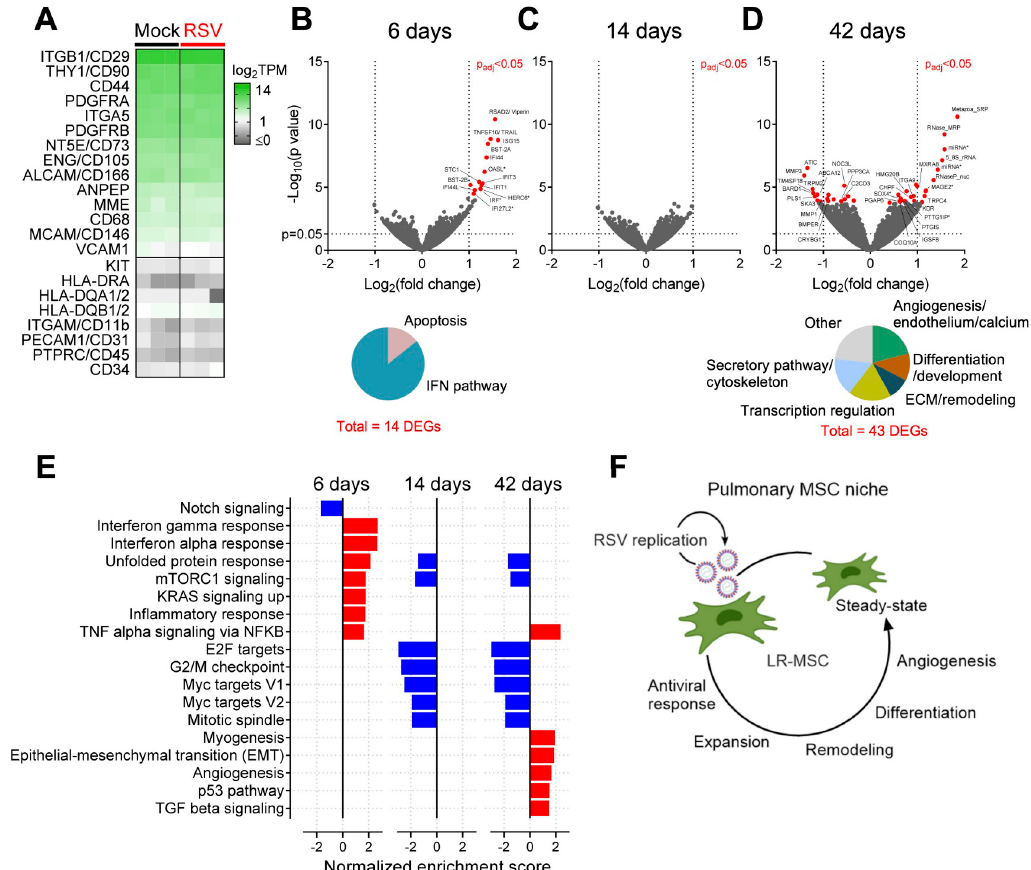
Fig 6. The transcriptional activity of LR-MSCs is related to the phases of RSV disease. (A) Expression levels of selected classical MSC markers expressed as log 2 TPM (TPM, transcripts per million). Each column is a different time p.i. (6, 14, and 42 days p.i.). (B-D) Volcano plots of the DEGs from the comparison of RSV infection and mock control 6 (B), 14 (C), and 42 (D) days p.i. with p adj < 0.05 (red filed circles). (B) Pie chart with the 14 DEGs 6 days p.i. (p adj < 0.05) categorized according to their function. (D) Pie chart with the 43 DEGs 42 days p.i. (p adj < 0.05) categorized according to their function. (E) Normalized enrichment score of significant (false discovery rate, FDR < 0.05) hallmark gene sets for the comparisons of RSV infection and mock control 6, 14, and 42 days p.i. (downregulated, blue and upregulated, red) (F) Illustration summarizing the different functions of LR-MSCs over the course of RSV